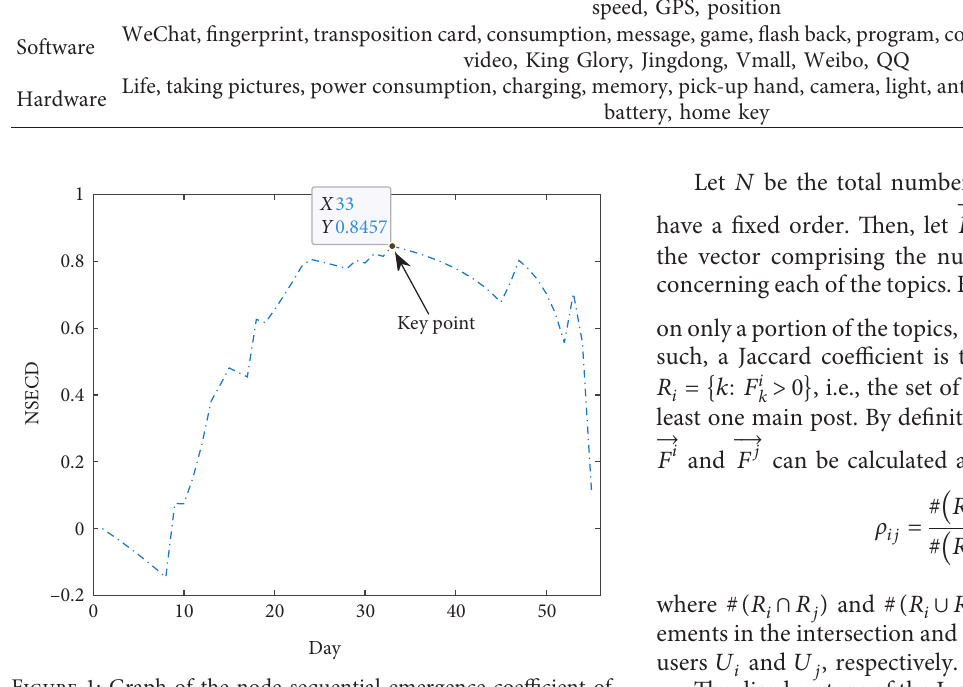
Figure 1: Graph of the node sequential emergence coefficient of determination.